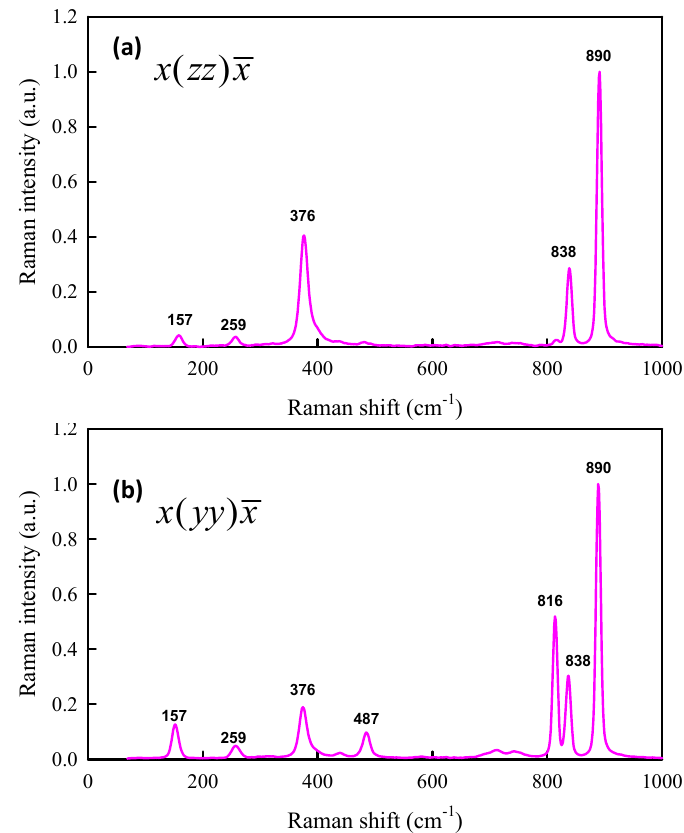
Figure 2. Spontaneous Raman scattering spectra with ( a ) x ( zz ) x and ( b ) x ( yy ) x configurations in a -cut YVO 4 crystal.